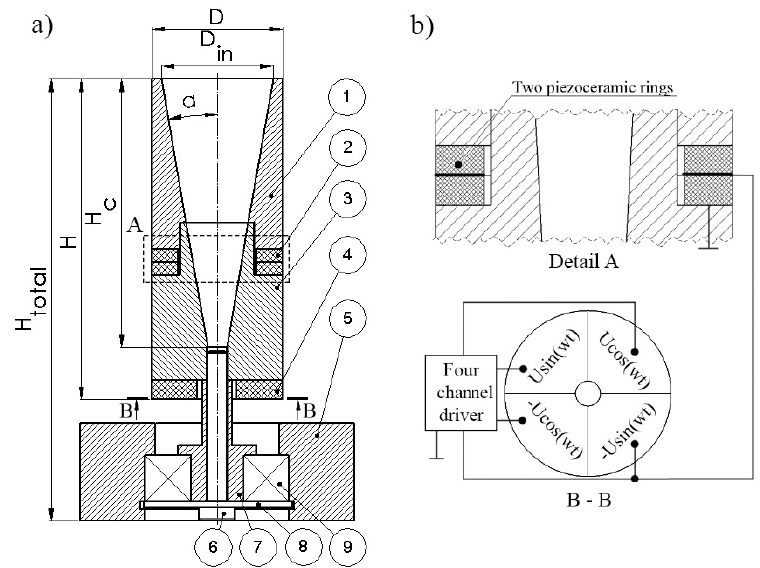
Figure 1. Schematics and excitation scheme of the traveling wave actuator: ( a ) Schematics of the traveling wave actuator: 1, the upper part of the waveguide; 2, the piezoceramic rings placed at the node; 3, the lower part of the waveguide; 4, the piezoceramic ring placed at the bottom of the waveguide; 5, the ball-bearing bed; 6, M3 fixing bolt; 7, the supporting cylinder; 8, the fixing ring; 9, the ball bearing. ( b ) Excitation scheme of the actuator.